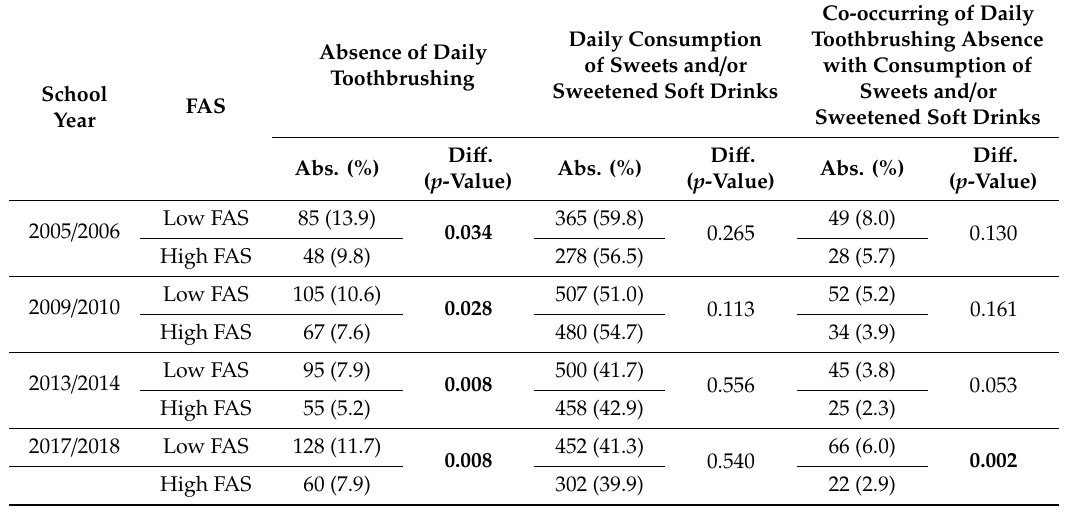
Table 3. Prevalence of the selected risk factors of caries by socioeconomic status in 11-13-year-old boys.